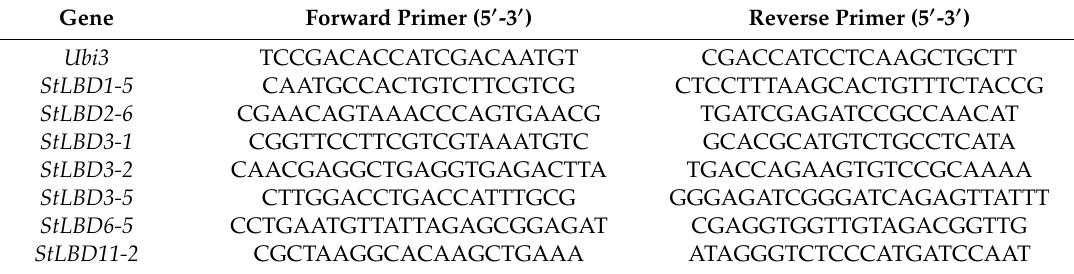
Table 2. qRT-PCR primers for expression in the analysis of StLBD .